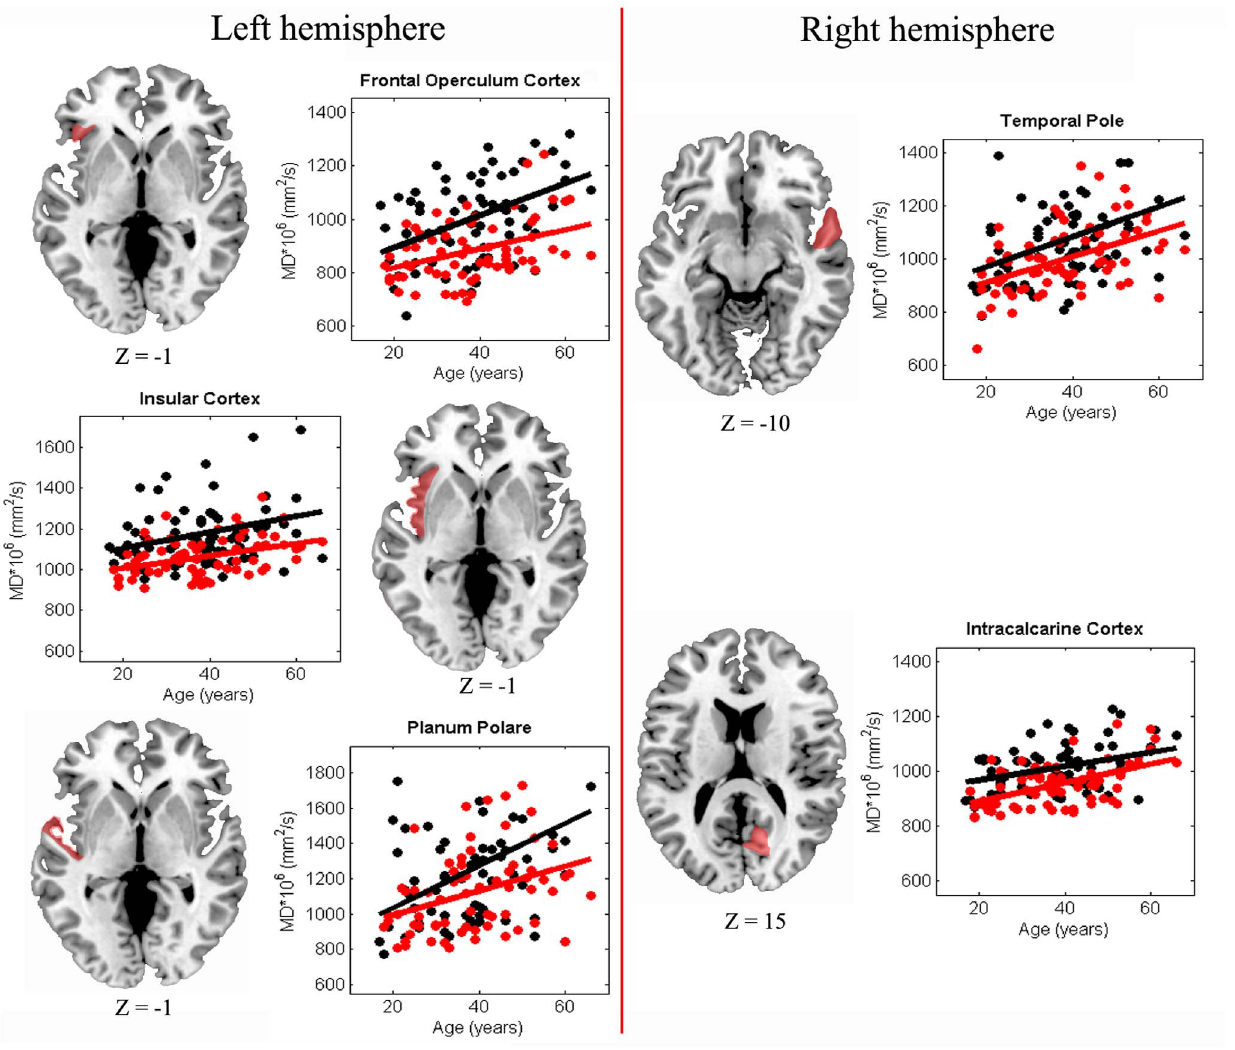
Figure 2. Age-related trajectories of MD within cortical GM of SZ and HC subjects. Scatter plot of MD (* 10 6 cm 2 /s) as a function of age for SZ (white circles) and HC (red circles). Solid lines represent linear fits for each group. Representative axial slices of the brain are reported for each hemisphere. Cortical regions in which the aging path followed by MD is different in SZ and HC are marked in red. Z coordinates are indicated in MNI space.